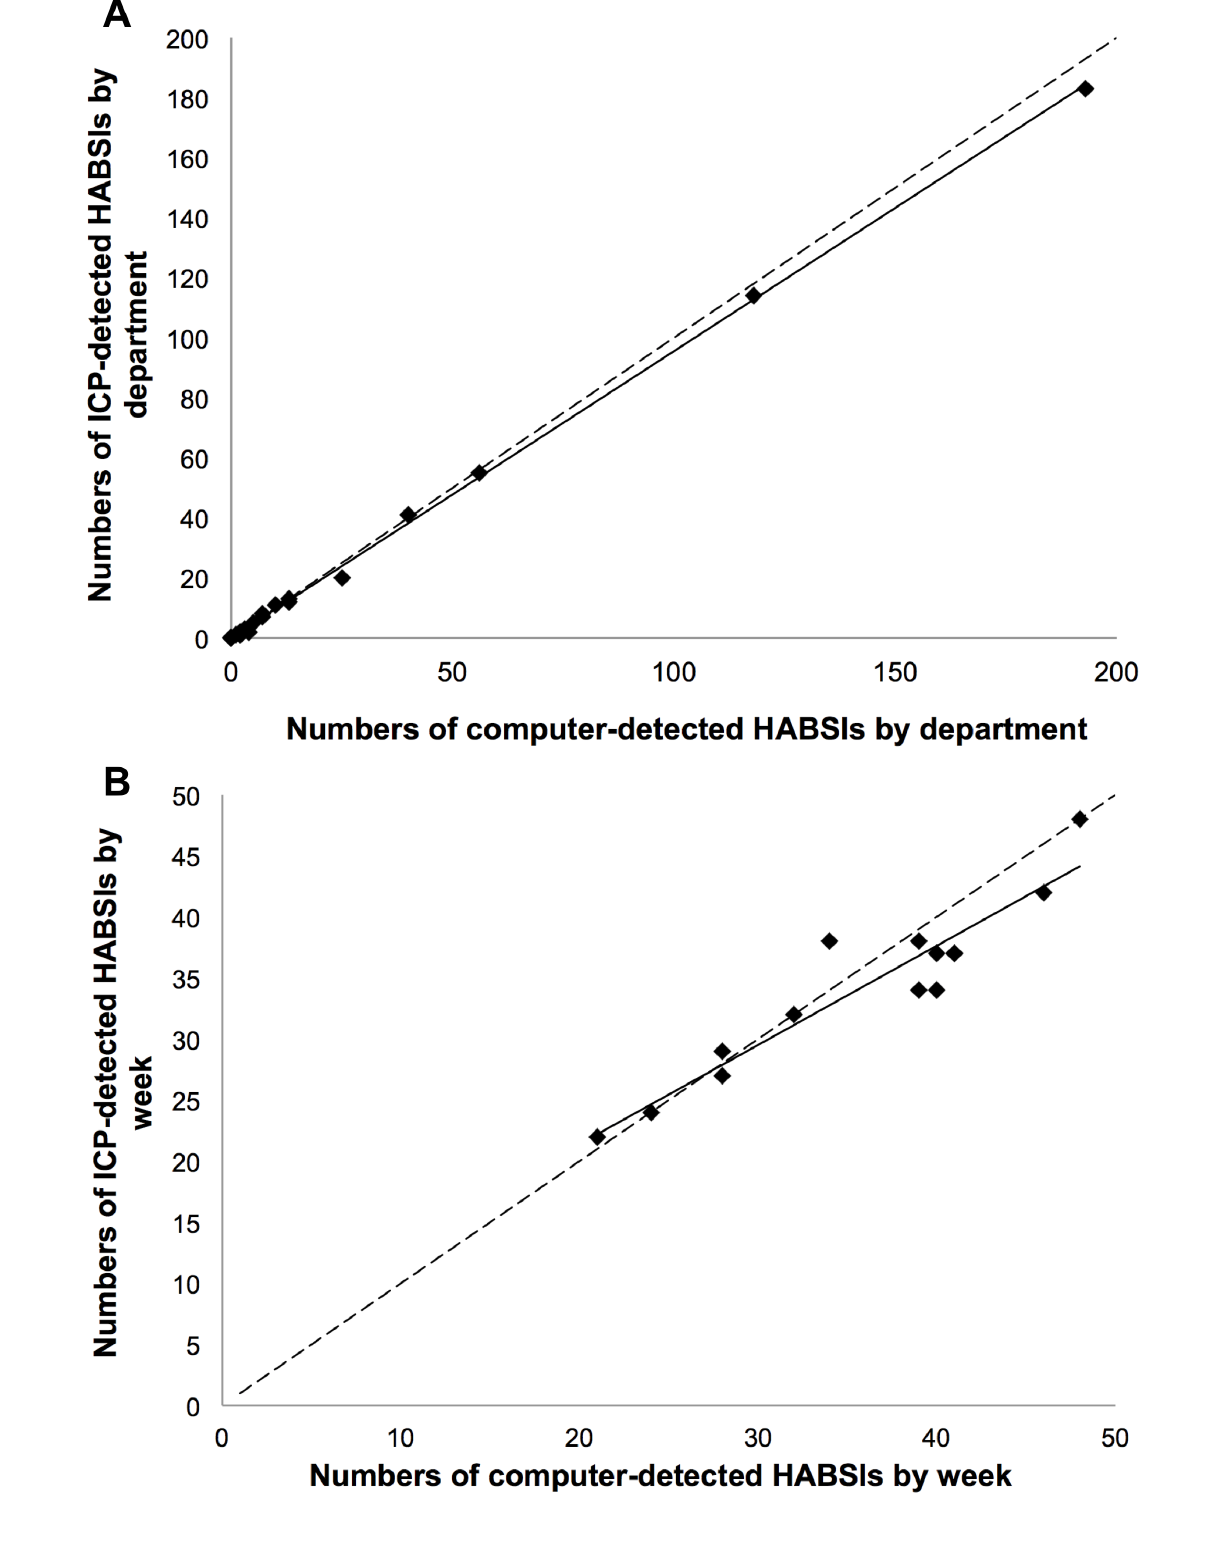
Figure 4. Correlation of 501 episodes of infection control personnel (ICP)-detected health care-associated bloodstream infection (HABSI) and 479 episodes of computer-detected HABSI from 20 departments during the 14-week study period. (A) Perfect agreement of HABSI episodes by department (n=20, Pearson correlation, r <.999, P <.001). (B) Perfect agreement of HABSI episodes by time (n=14, Pearson correlation, r =.941, P